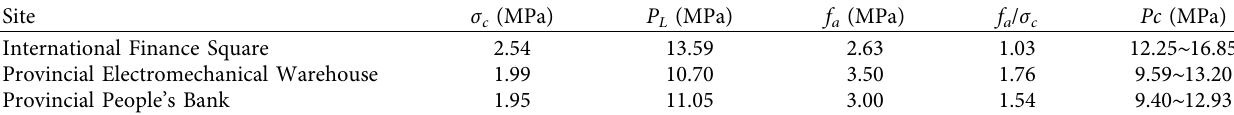
Table 1: Verification of rock foundation loading tests.